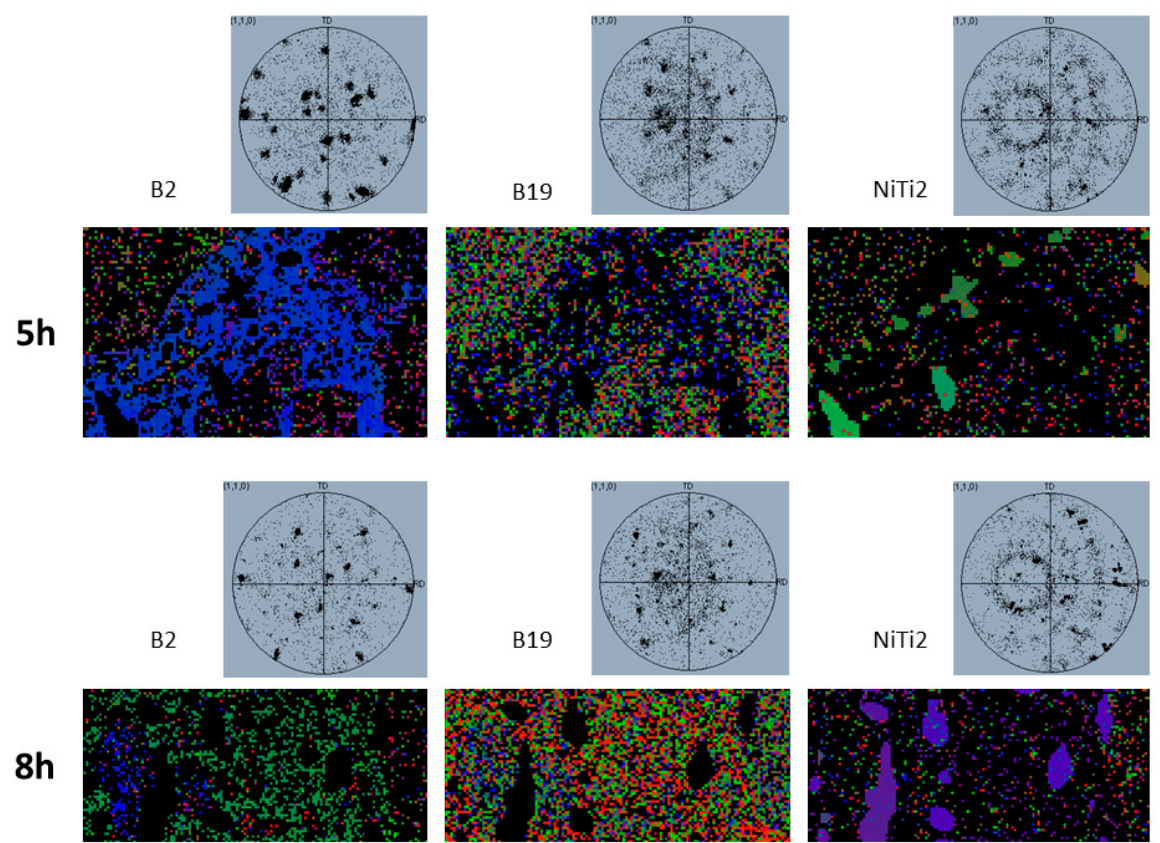
Figure 9. Results of the EBSD analysis performed on samples 850C5h and 850C8h. For each identified structure (B2, B19, and NiTi 2 ) the pole figures (up) and the orientational maps of the normal direction with respect to the sample (down) are shown.